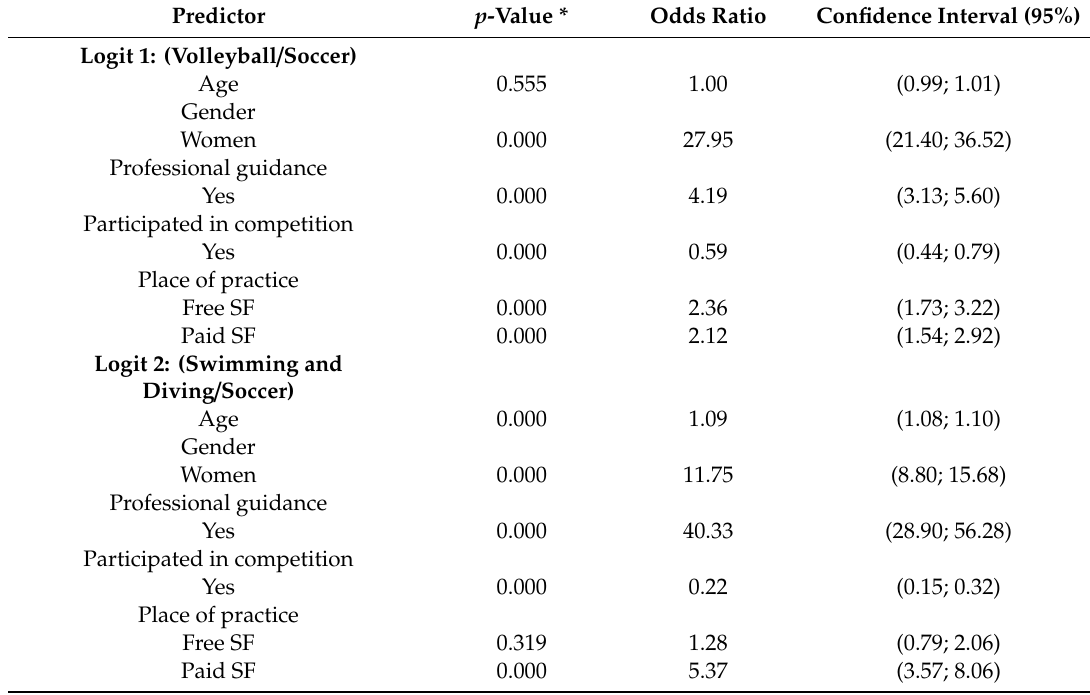
Table 6. Main results of the nominal logistical regression—main sport